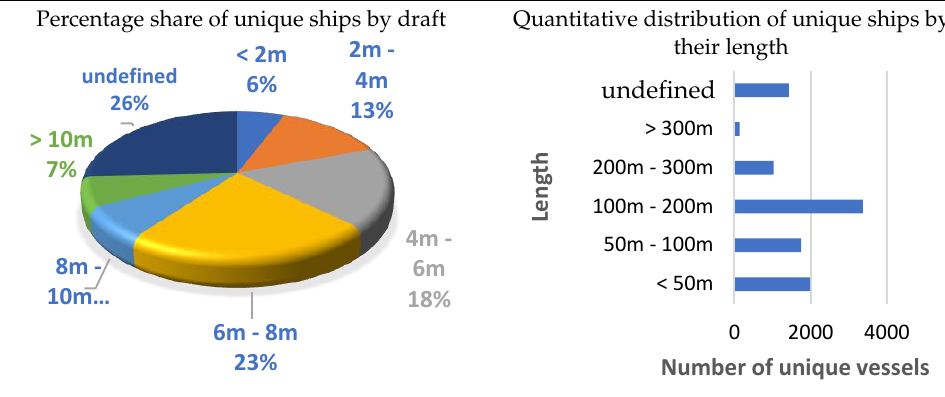
Table 3. Qualitative characteristics of fishing vessels.